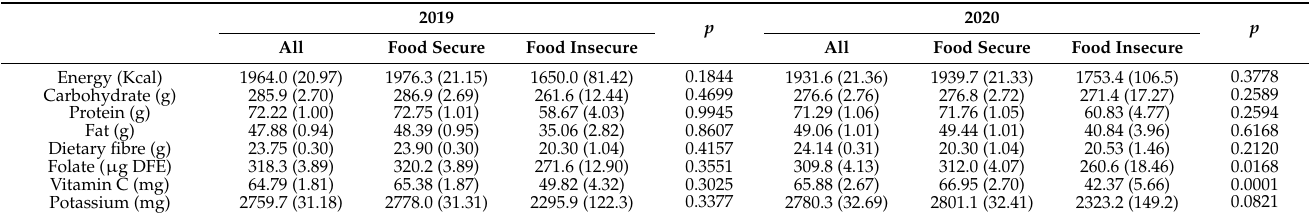
Table 3. Nutrient intake level by food security status in 2019 and 2020 (mean and